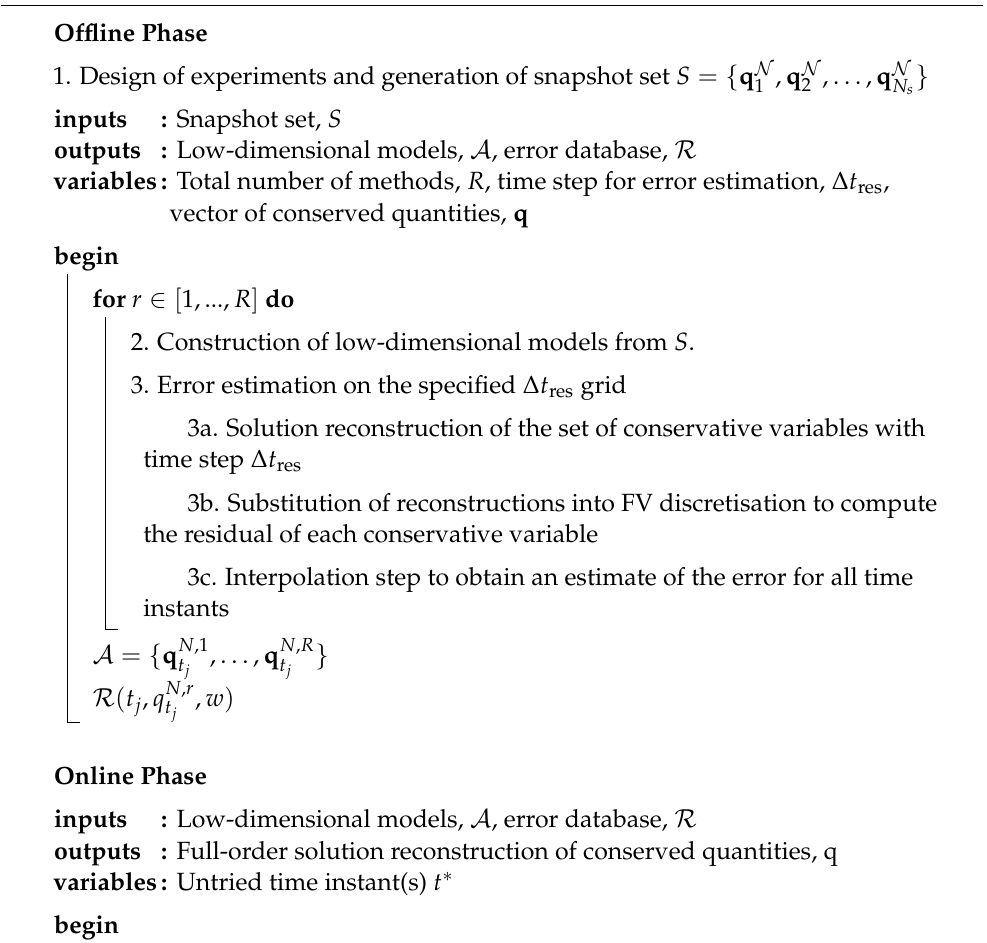
Algorithm 1: Adaptive reduced order modelling